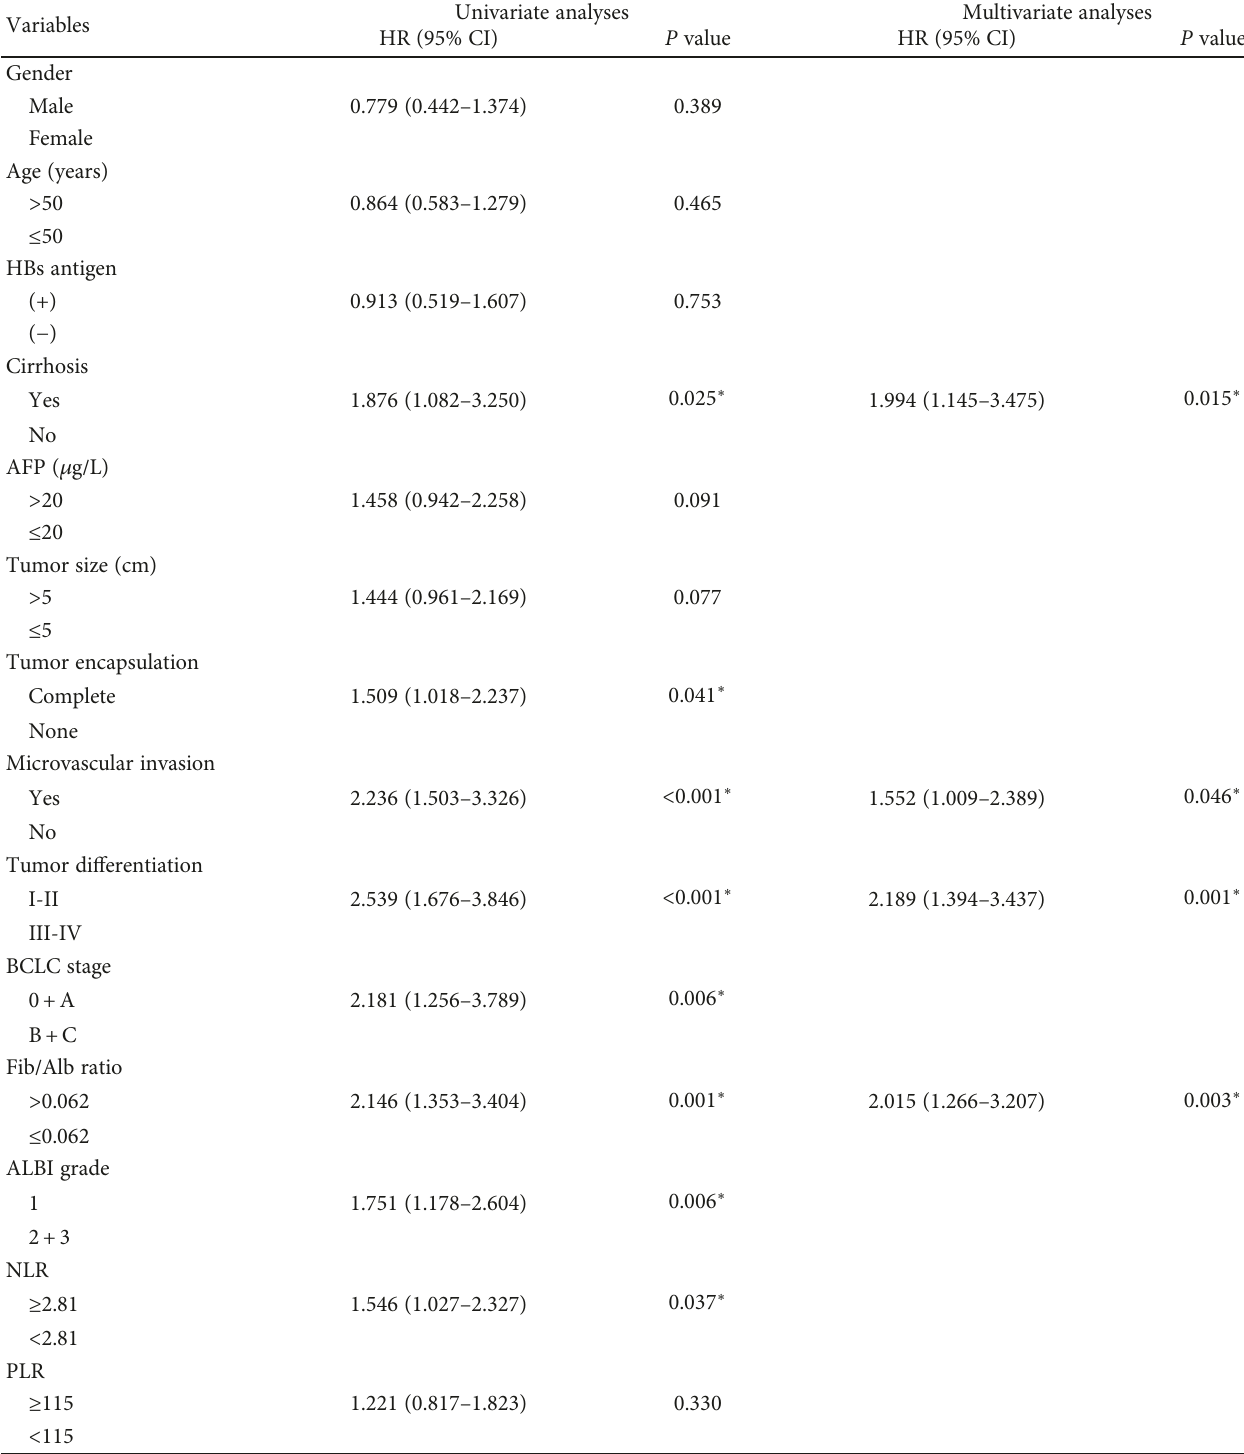
Table 2: Univariate and multivariate Cox regression analyses of prognostic factors for overall survival